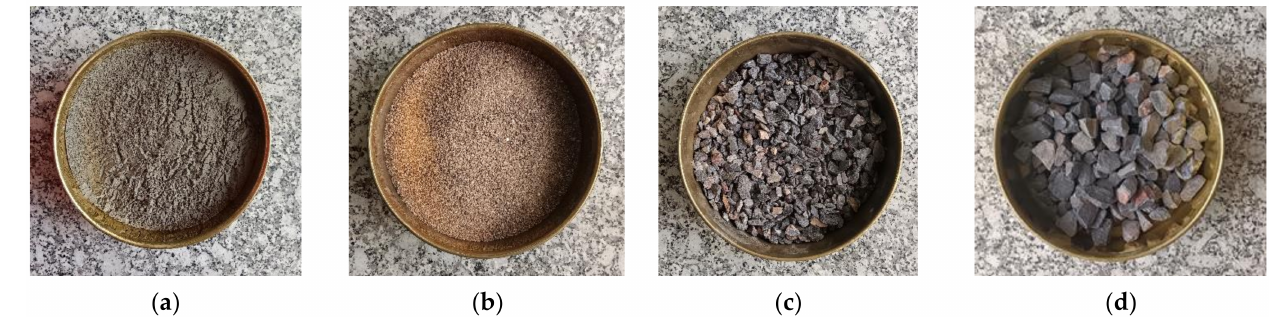
Figure 1. ( a ) Commercial cement; ( b ) river sand; ( c ) natural coarse aggregates (NCA)—10 mm; ( d ) natural coarse aggregates (NCA)—20 mm.